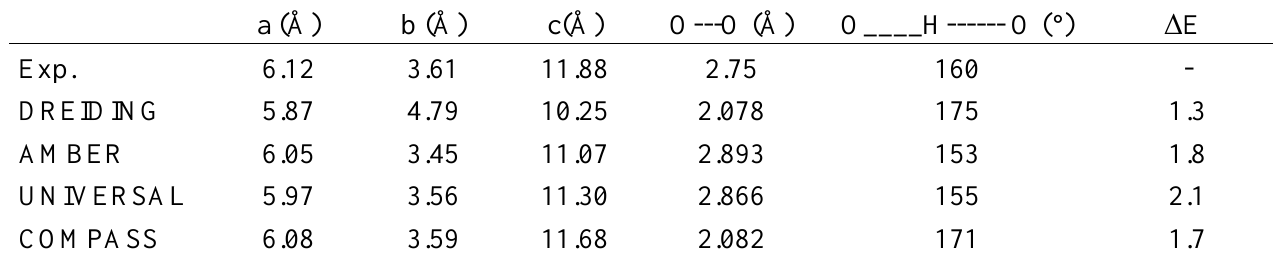
Table II. Cell Axes, Hydrogen-Bond Geometries, and Lattice-Energy Minima of L-Ascorbic Acid Corresponding to the Experimental Structure, for Different Force Fields [31].